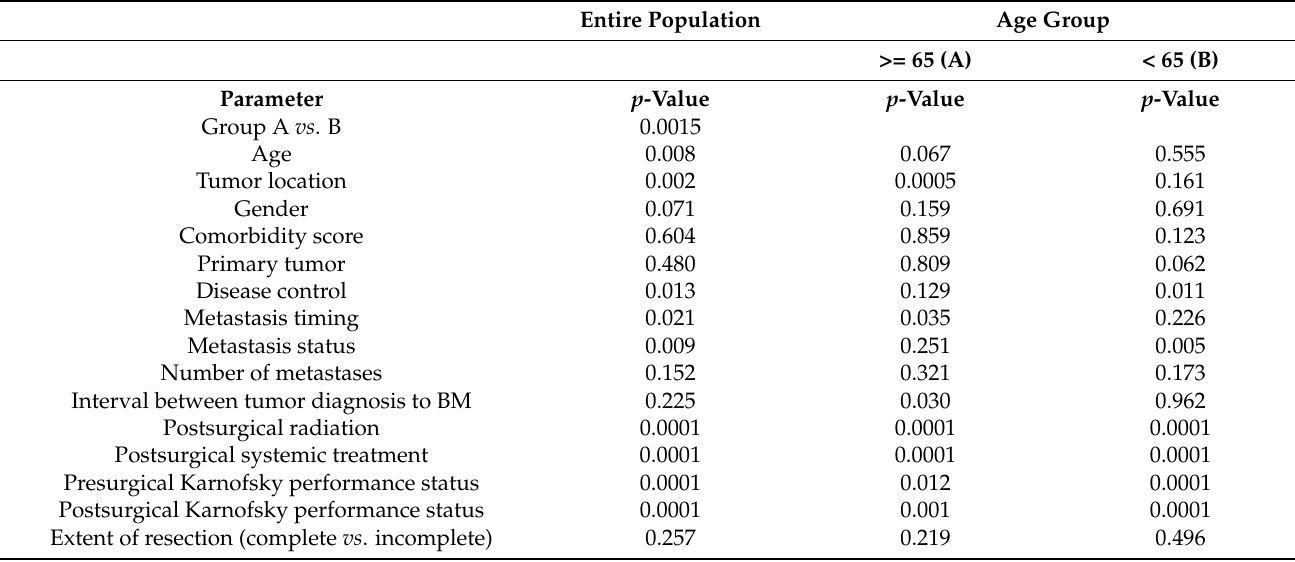
Table 2. Univariate analysis of factors associated with overall survival.